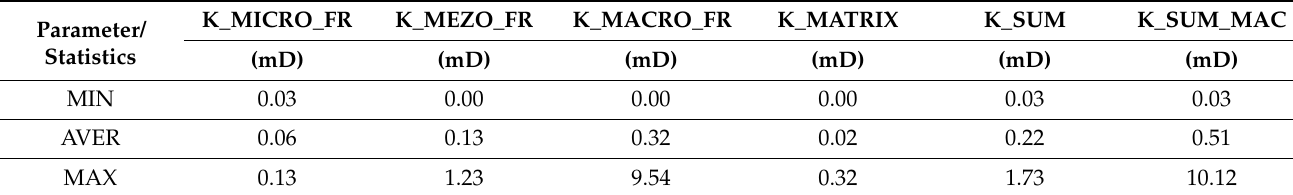
Table 5. Simple statistics (MIN—minimum, AVER—average, MAX—maximum) of the permeability from logs and laboratory data integration. G-10